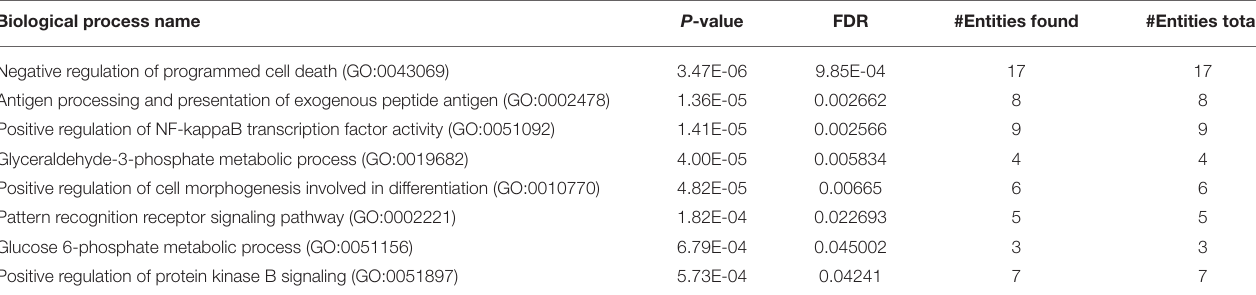
TABLE 2 | GO enrichment analysis (biological process) of the proteome of co-cultured PBMC vs. PBMC alone. Biological process